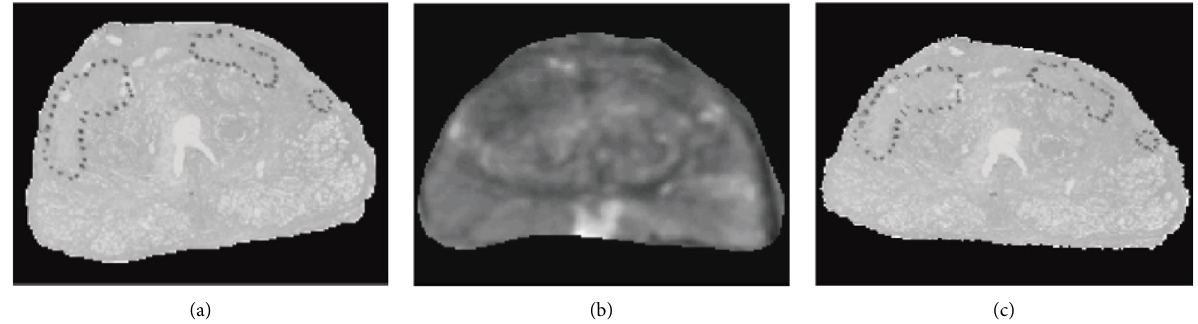
Figure 7: Aligned histological slide and MRI-plan of human prostate tissue through the group-wise scheme proposed by [10]. A histological slice of human prostate tissue (a) was through the group-wise alignment matched with a candidate MRI plane (b) and then afnely registered (c). Te dotted polygons in (a) and (c) represent cancer cell distributions marked by experts. Reprinted from computerized medical